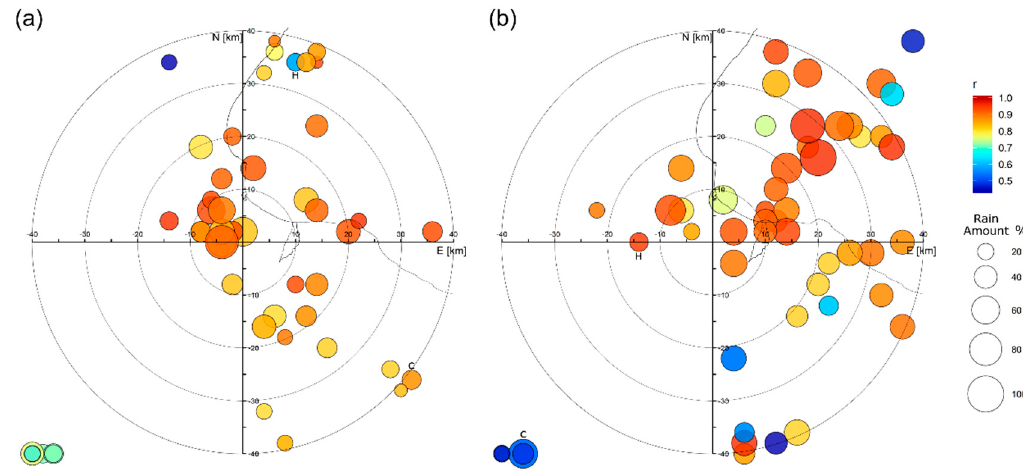
Figure 5. Location of the rainfall peaks within an 80 km-side squared box centered on the Corigliano rain gauge for the high-resolution forecast (letter “H” inside the circle), the low-resolution control forecast (letter “C”), and the 50 perturbed simulations, for the forecasts starting at ( a ) 0000 UTC and ( b ) 1200 UTC on 11 August 2015. The colors represent the time correlation of the series of accumulated precipitation with observations ( r is the correlation coefficient), while the size indicates the percentage rainfall amount with respect to observations. The circles on the bottom-left and upper-right corners account for the perturbed forecasts with rainfall peaks at the border of the boxes. The borders of the Citrea creek catchment are also represented.